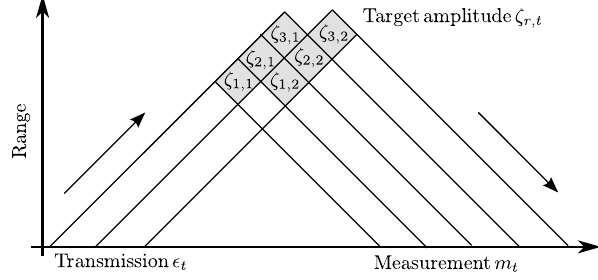
Fig. 1. Simplified range-time diagram of backscatter from a strong narrow region (notice that this is not in round-trip time). In this example there are two transmit samples and three ranges that cause backscatter. The gray area represents the area where the backscatter of one sample originates from, assuming boxcar impulse response. A longer impulse response will cause more range spreading. in round-trip time at one sample intervals, t also denotes time in samples. By convention, we apply a range dependent con- stant r delay, so that the range dependent backscatter ampli- 2 tude is ζ r,t instead of ζ r,t − r . Fig. 1 depicts backscatter from 2 three range gates probed with two transmission samples. To simplify matters, we use overlapping triangular range gates.